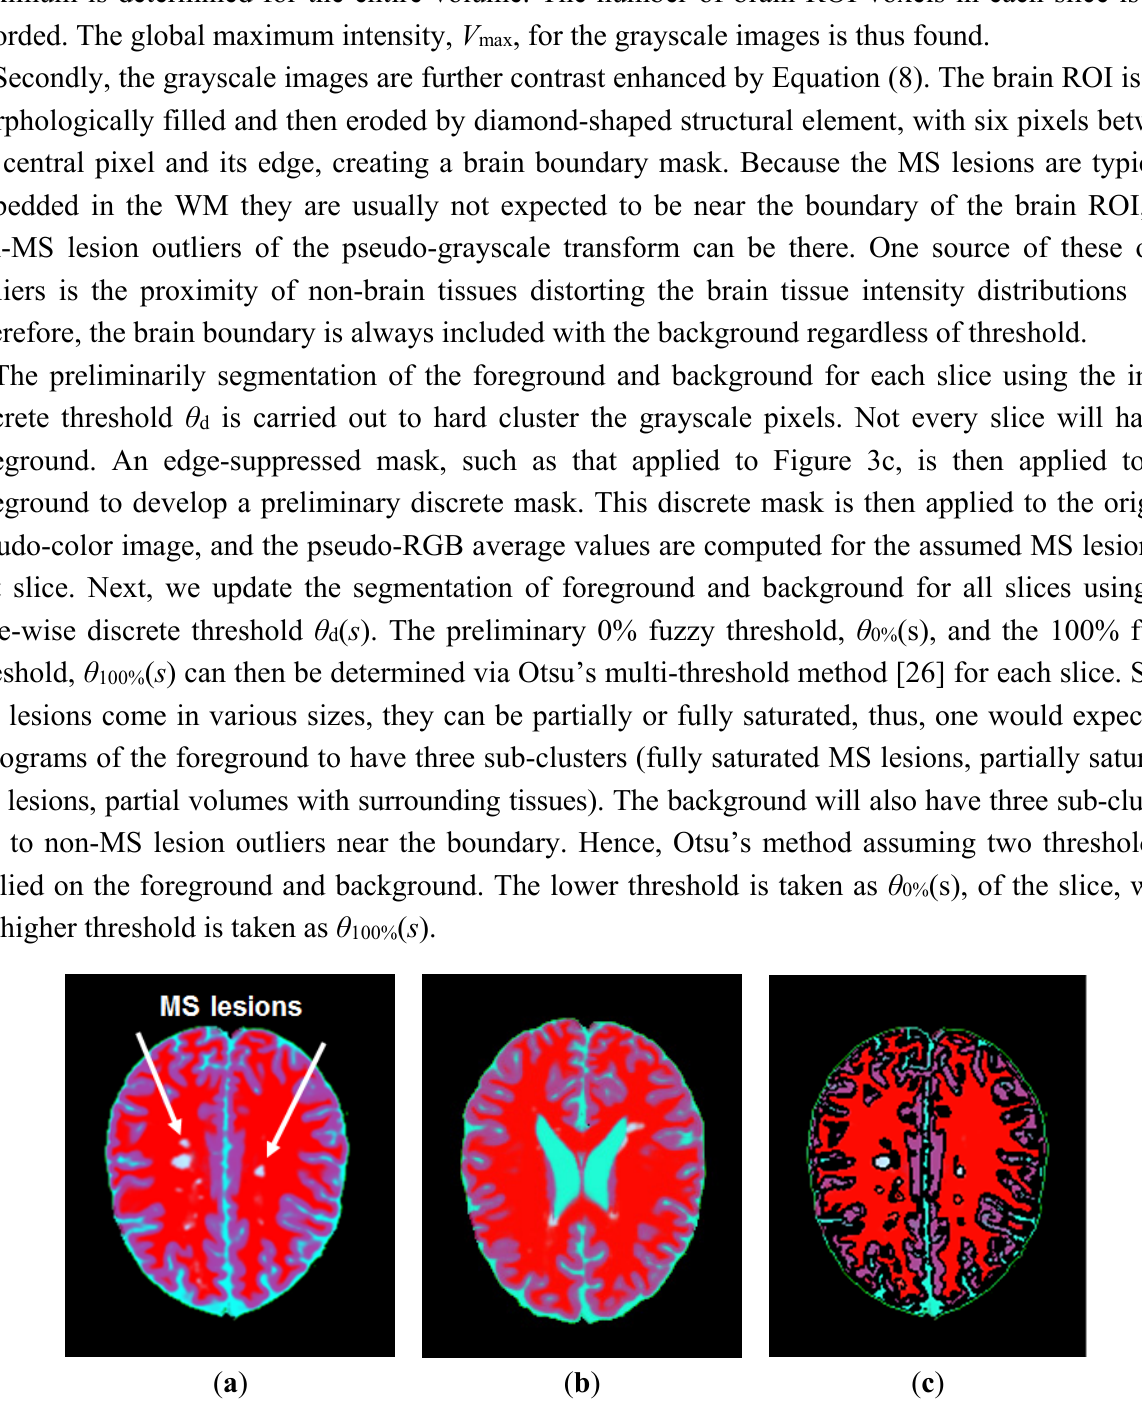
Figure 3. ( a ) The pseudo-color MR image encoding all major weightings for slice 105 of a BrainWeb brain volume with moderate MS lesions. Hyperintense MS lesions stand out as whitish spots; ( b ) the pseudo-color for slice 95 used to estimate tissue averages; ( c ) the 3D edge suppressed image of (a) that can be used as a sampling mask for further segmentation of non-WM tissues and again to estimate average tissue